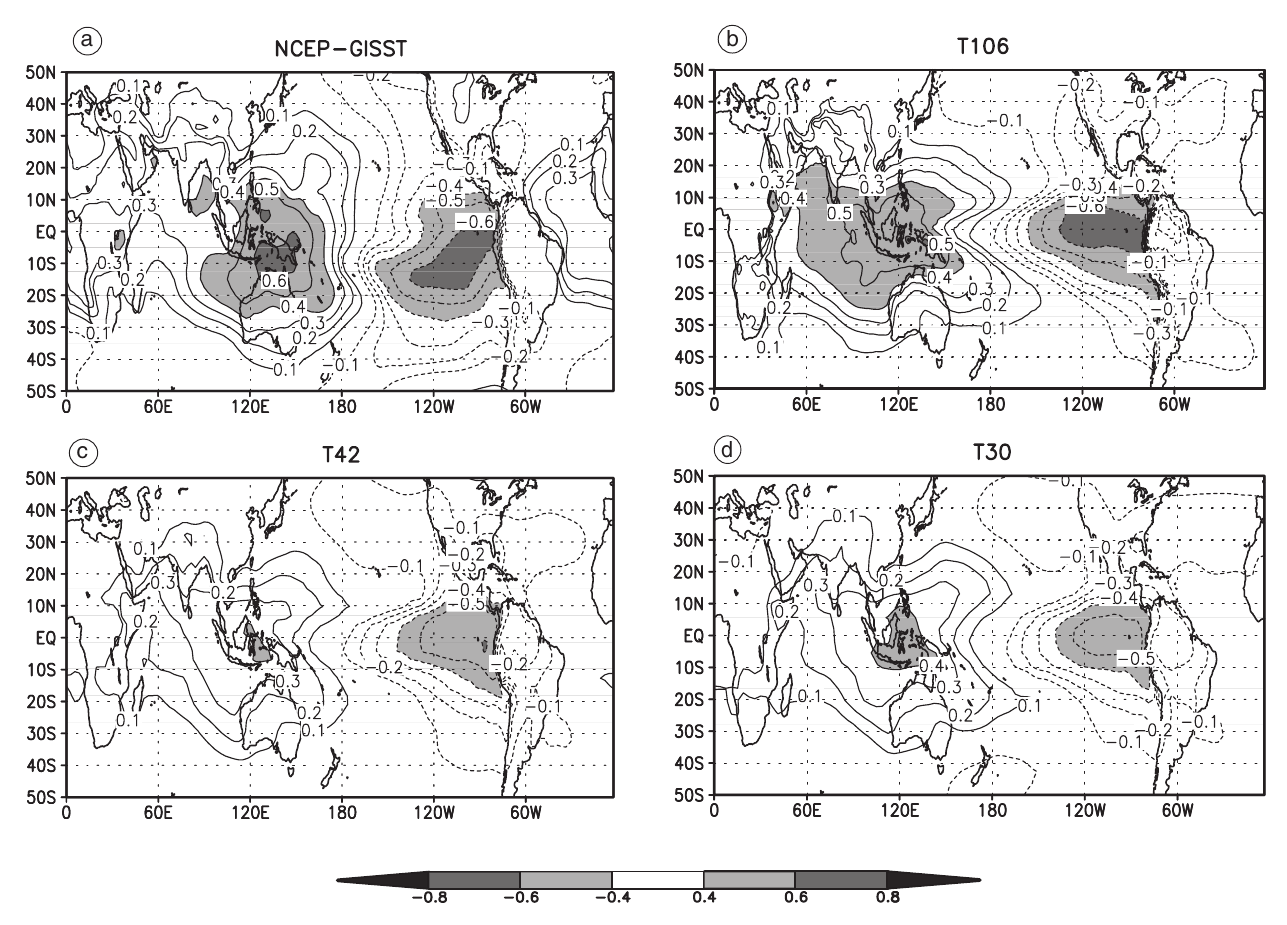
Fig. 15a-d. Maps of correlation of the NIÑO-3 SSTA time series with the global Sea-Level Pressure (SLP) anomaly. Panel a): NCEP-GISST case; panel b): T106 experiment; panel c): T42 experiment; panel d): T30 experiment. Contour line interval is 0.1; dashed contour lines indicate negative values; shaded areas indicate values larger than | 0.4 | ; the shaded contour interval is